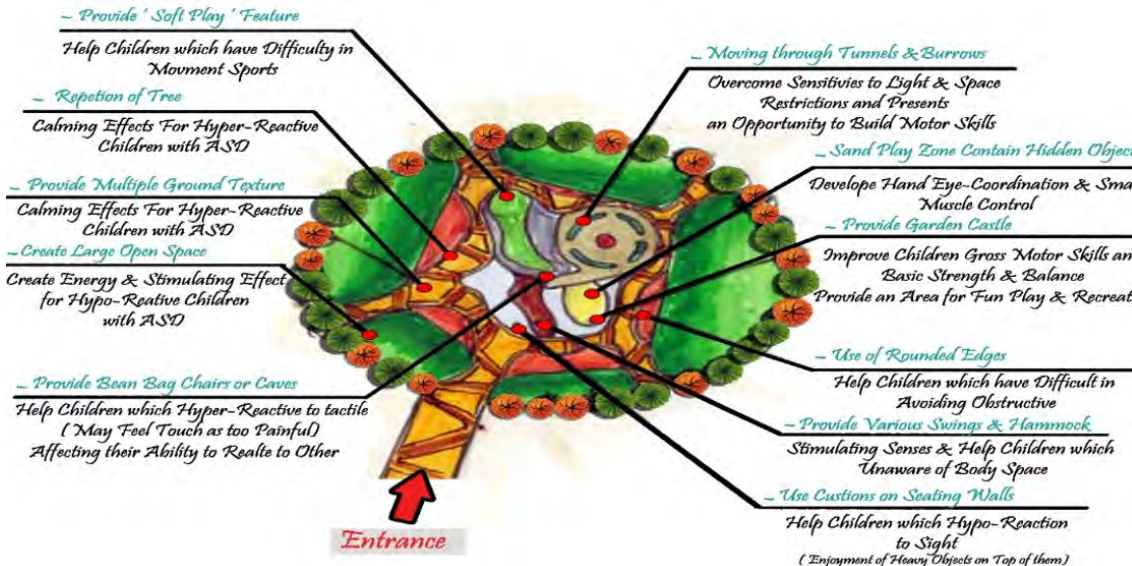
Figure 15. Shows the design consideration for the fine and gross motor skills zone